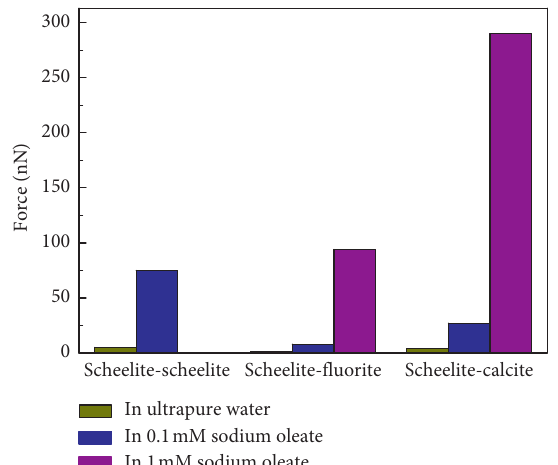
Figure 19: The adhesion force on scheelite-scheelite, scheelite-fluorite, and scheelite-calcite in retraction curves at pH 10.